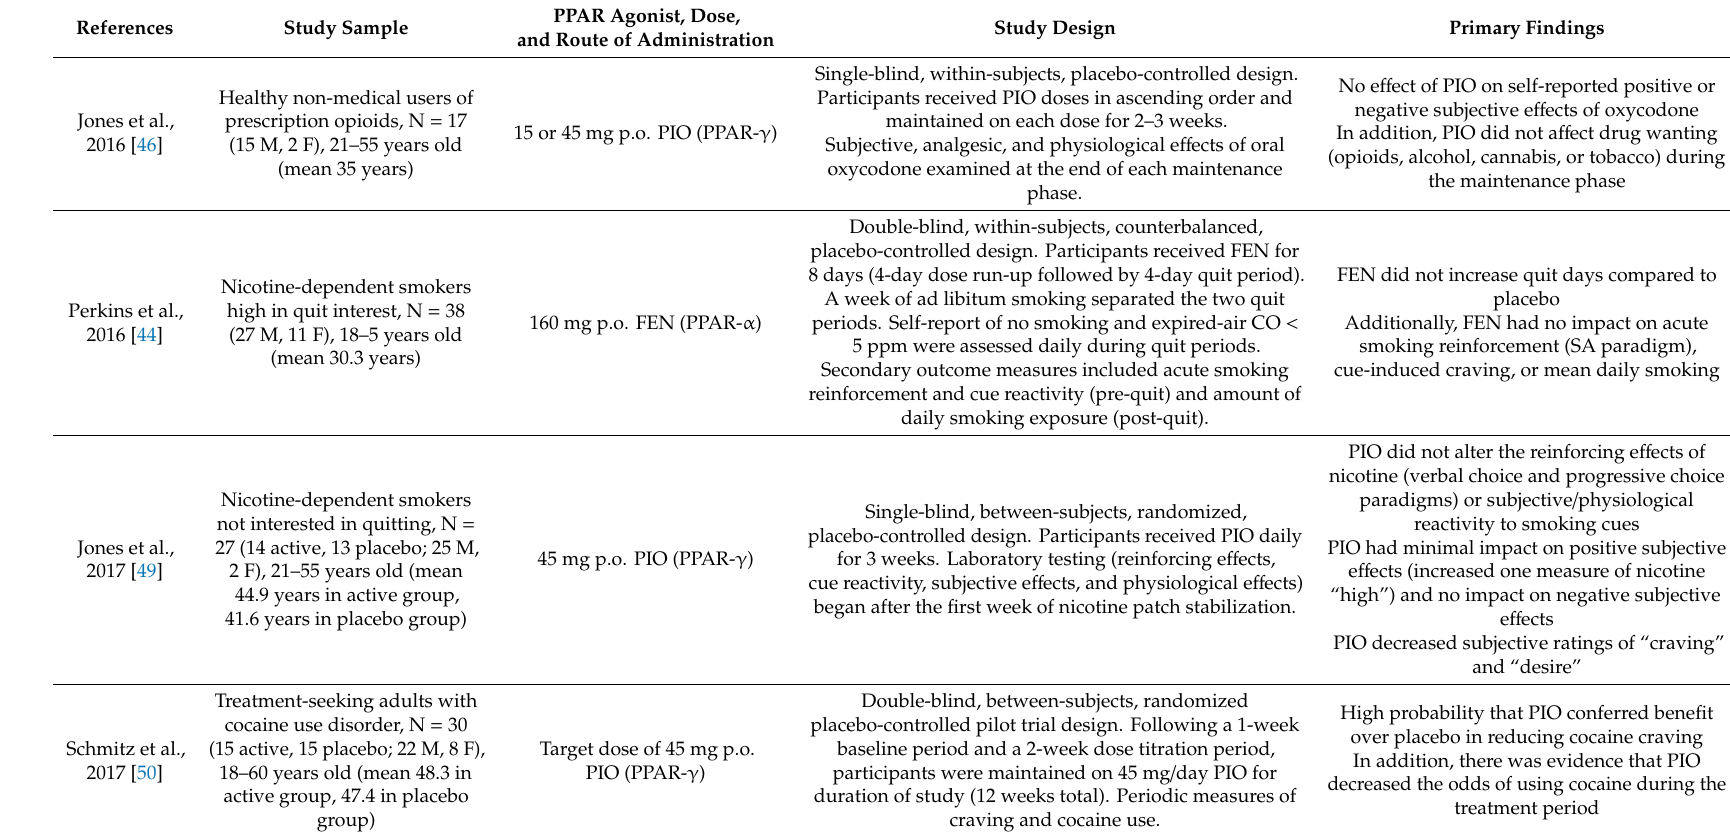
Table 2. Overview of methodological details and primary findings of the key clinical and human laboratory studies of PPAR agonists in drug-related